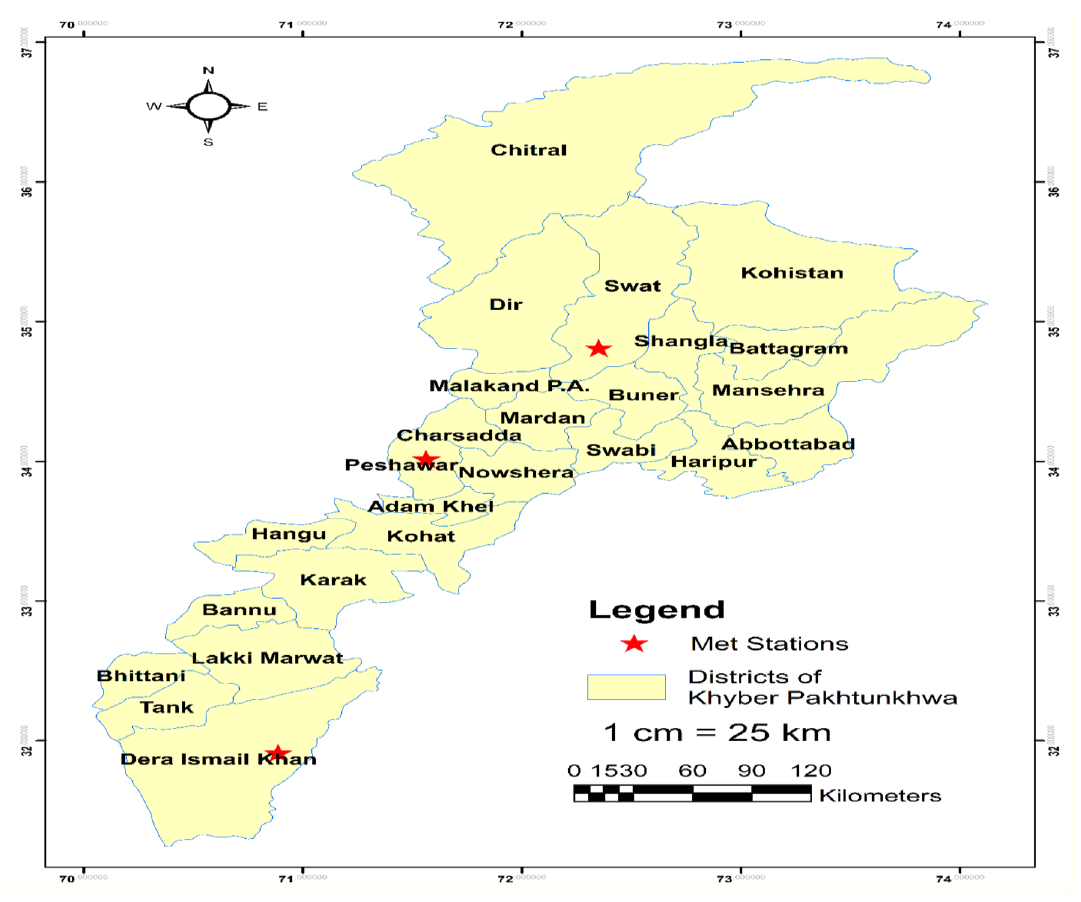
Fig. 1 Kp map indicating the particular station. Source : Unpublished thesis